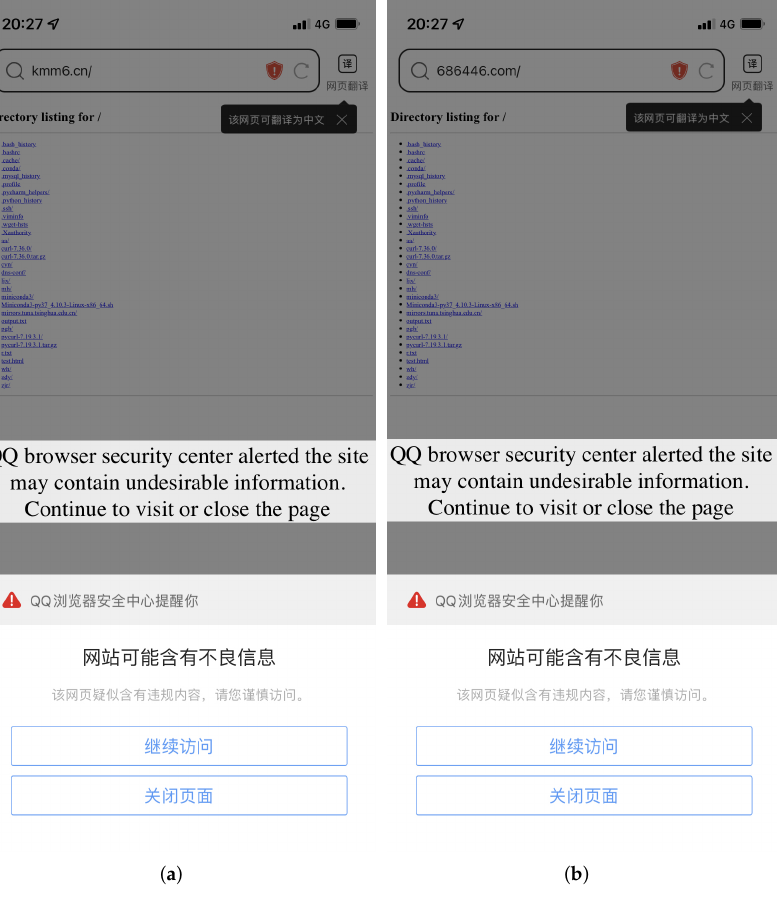
Figure 14. Using QQ browser accesses two non-abusive domains. ( a ) kmm6.cn. ( b )